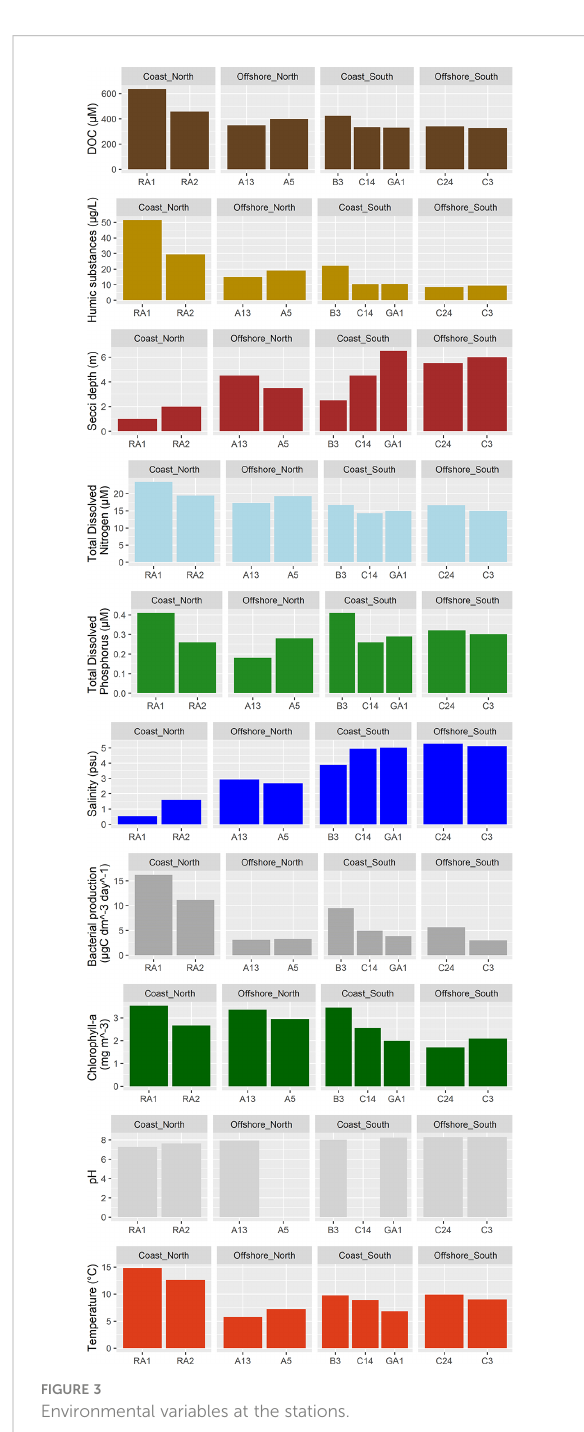
FIGURE 3 Environmental variables at the